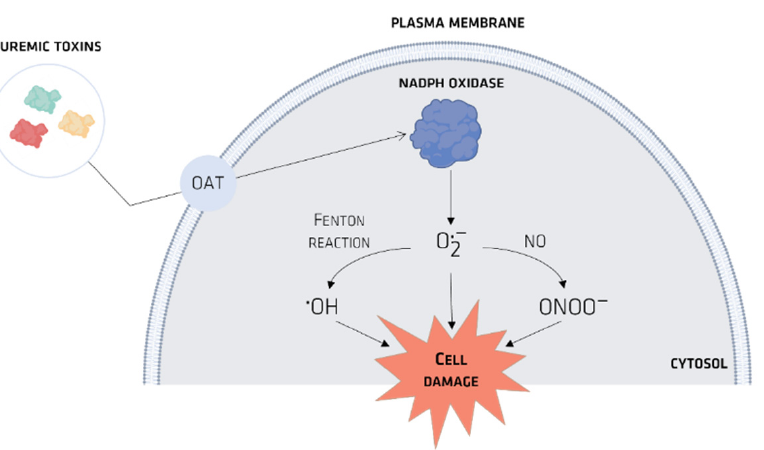
Figure 4. UTs-induced ROS production.